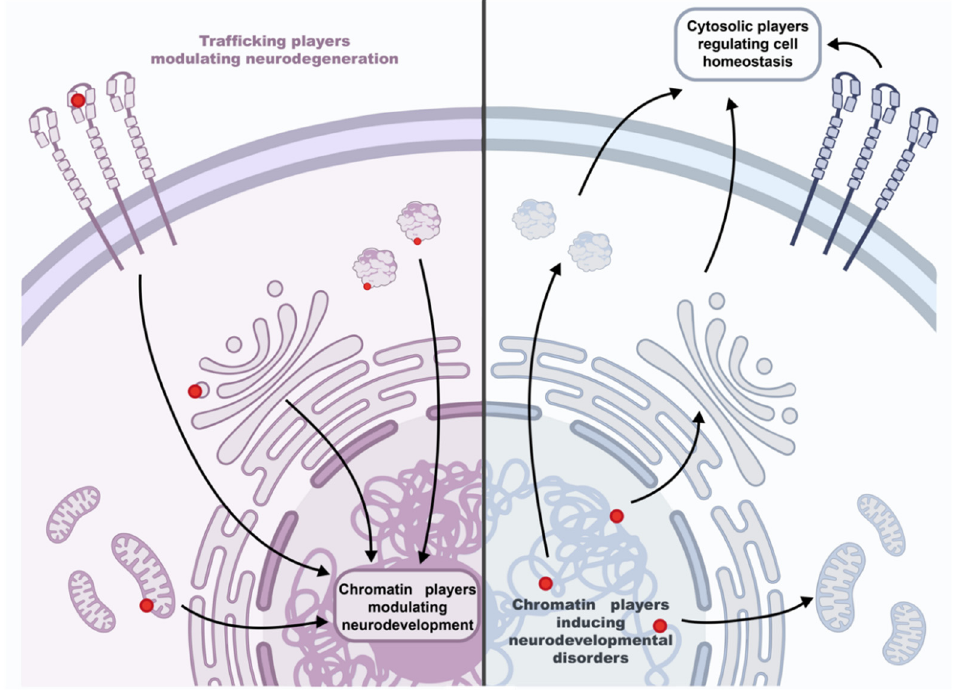
Figure 5. Schematic model of the interplay between nuclear and cytosolic factors in the progression of neurodevelopmental and neurodegenerative disorders. Left panel: mutations (red dots) in traf- ficking and cytosolic players known to cause neurodegeneration. However, they might also act on chromatin players regulating neuronal development, exacerbating neuronal degeneration. Right panel: chromatin players known to cause neuronal development disorders might also affect cytosolic players involved in maintaining cell homeostasis.